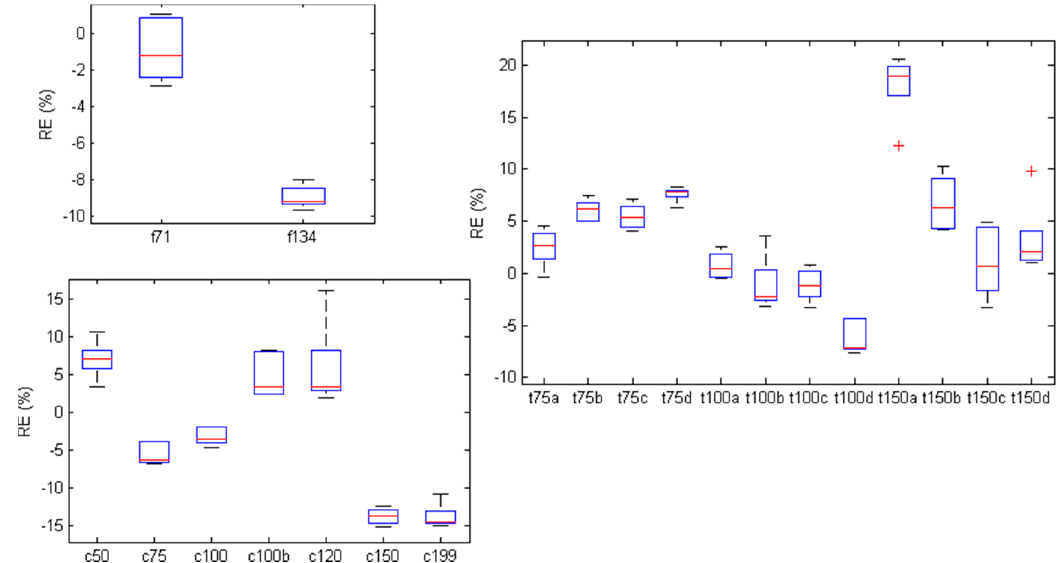
Figure 5. dispersion diagrams.